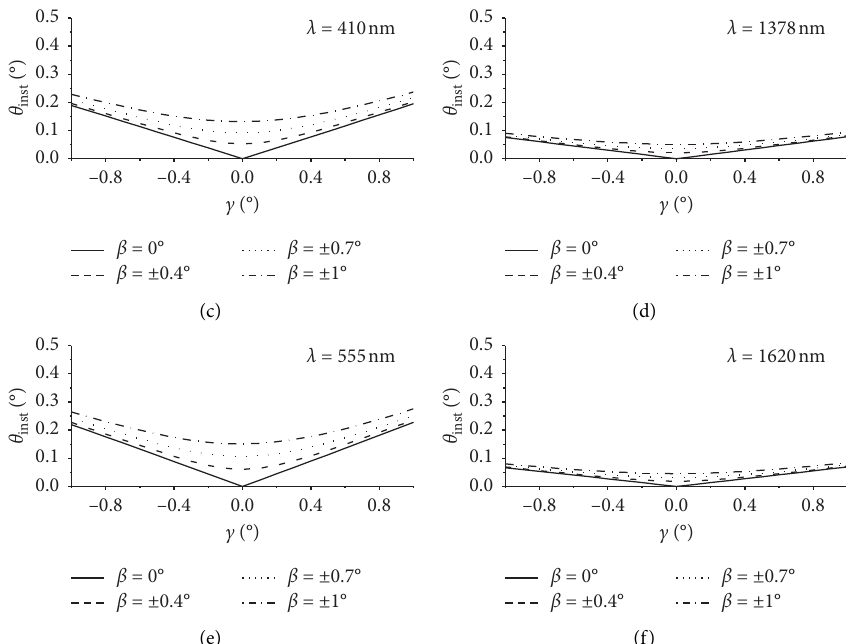
Figure 8: Dependence of the extremum value of azimuth θ inst of the instrumental polarization of the TSM on the mirror M 2 tilt around axes 1 and 2 (as shown in Figure 5) at degrees of linear polarization p 0 �